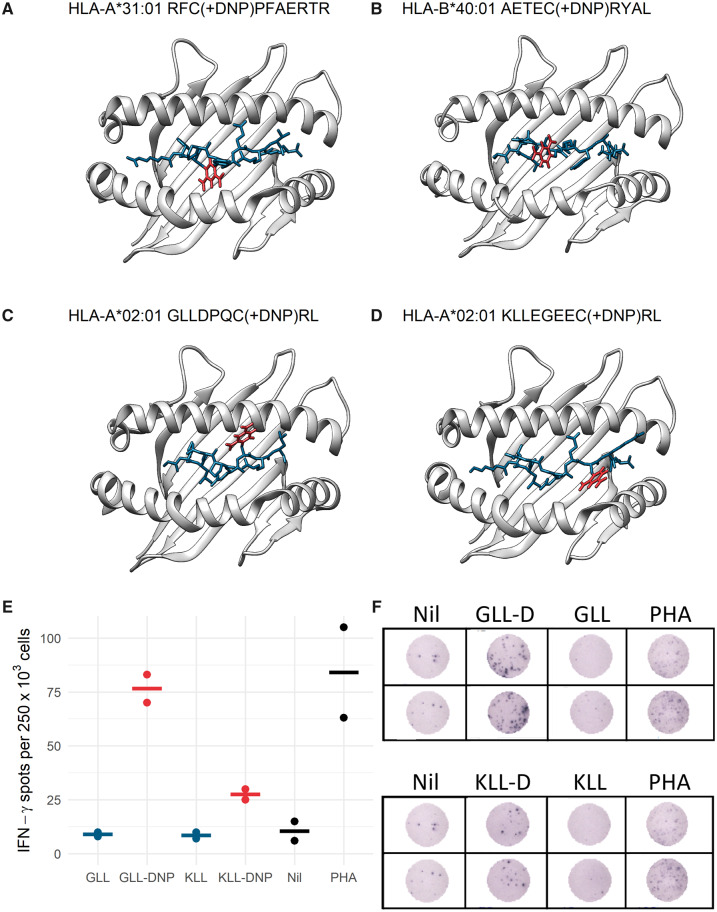
DNCB modified HLA peptides model structures and functional assay: A, B, C, D, Homology models of DNP modified peptides: Putative structures were created of the DNP modified peptides using USCF Chimera (Pettersen et al., 2004; Shapovalov and Dunbrack, 2011) using PDB: 1IM3. E, F, Representative images from ex vivo IFN-γ ELISpot assay or enumerated spots after short term culture. Freshly isolated PBMC from an HLA-A*02:01 individual IMS1 were incubated with dinitrophenylated HLA-A*A02:01 GLL-D, KLL-D, or matched nondinitrophenylated peptides (GLL, KLL) before activation in an ELISpot assay with nil, peptides, or phytohemagglutinin.